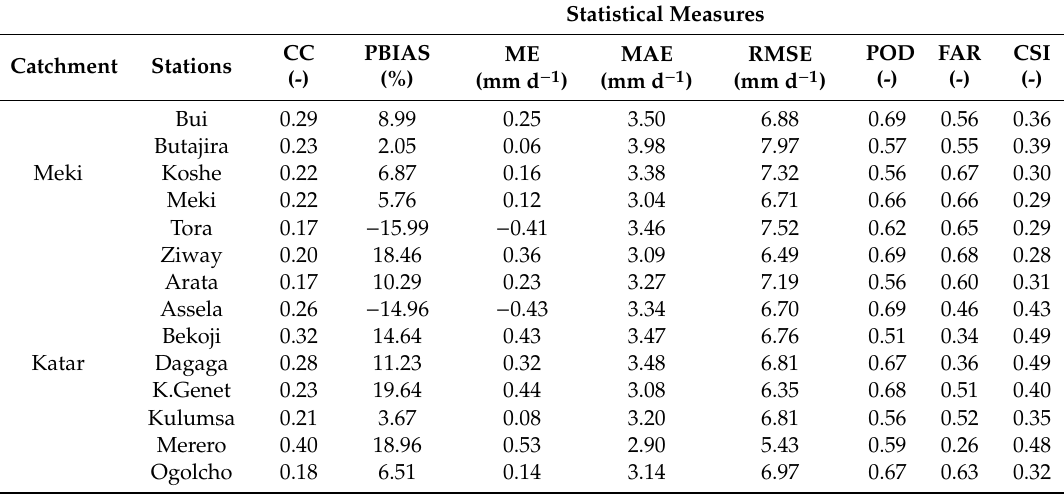
Table 3. Daily comparison of 14 rain gauges and the CHIRP satellite at point scale from 1985–2000. Statistical